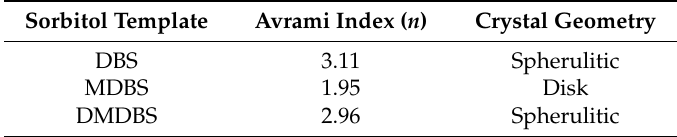
Table 1. Avrami index of wax crystallization using sorbitol templates.